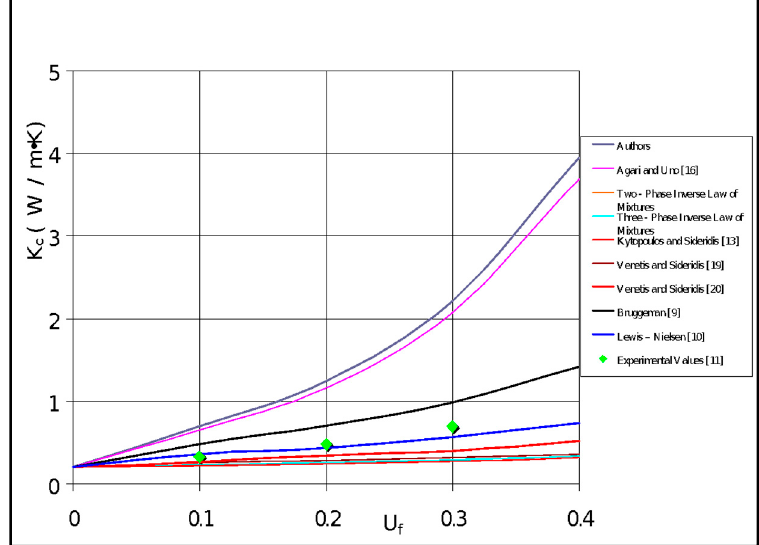
Figure 8. Theoretical predictions of thermal conductivity versus filler content at low and medium